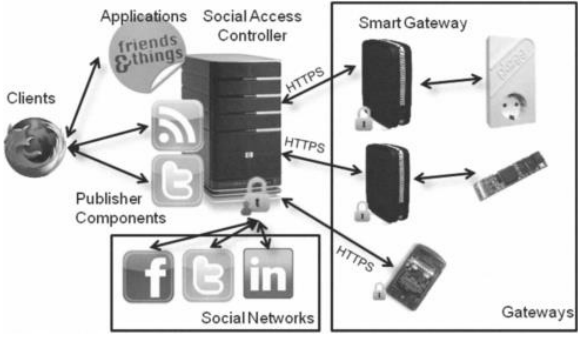
Figure 7. Social Web of Things (see [12]). But Data structuration is not the only use that has been found for SNSs into systems’ design. Social networking can equally be used as a way to organise manufacturing systems into distributed Dynamic Resource Communities (DRC) as a “new cyber-physical-social- connected and service-oriented manufacturing paradigm” [55]. This Social Manufacturing (SocialM) approach is based on the use of both socialized resources, social media, and social community inspired self-organization for resources (Figure 9). Resource agents (here named Production Service Providers or PSPs) are interacting with each other through a global social relationship network (e.g., the SNS), enabling them to self-organize into these distributed DRC, aiming to bring resiliency and flexibility to production systems.